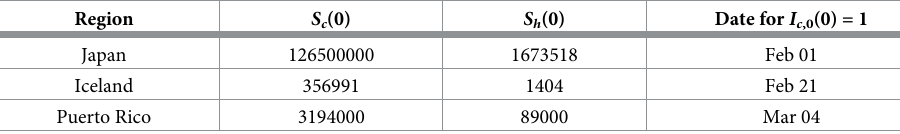
Table 4. Susceptible population for the three non-Hawaiian